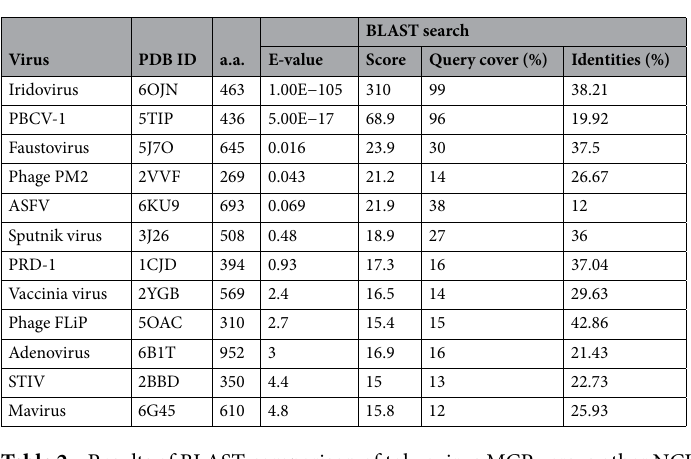
Table 2. Results of BLAST comparison of tokyovirus MCP versus other NCLDVs.